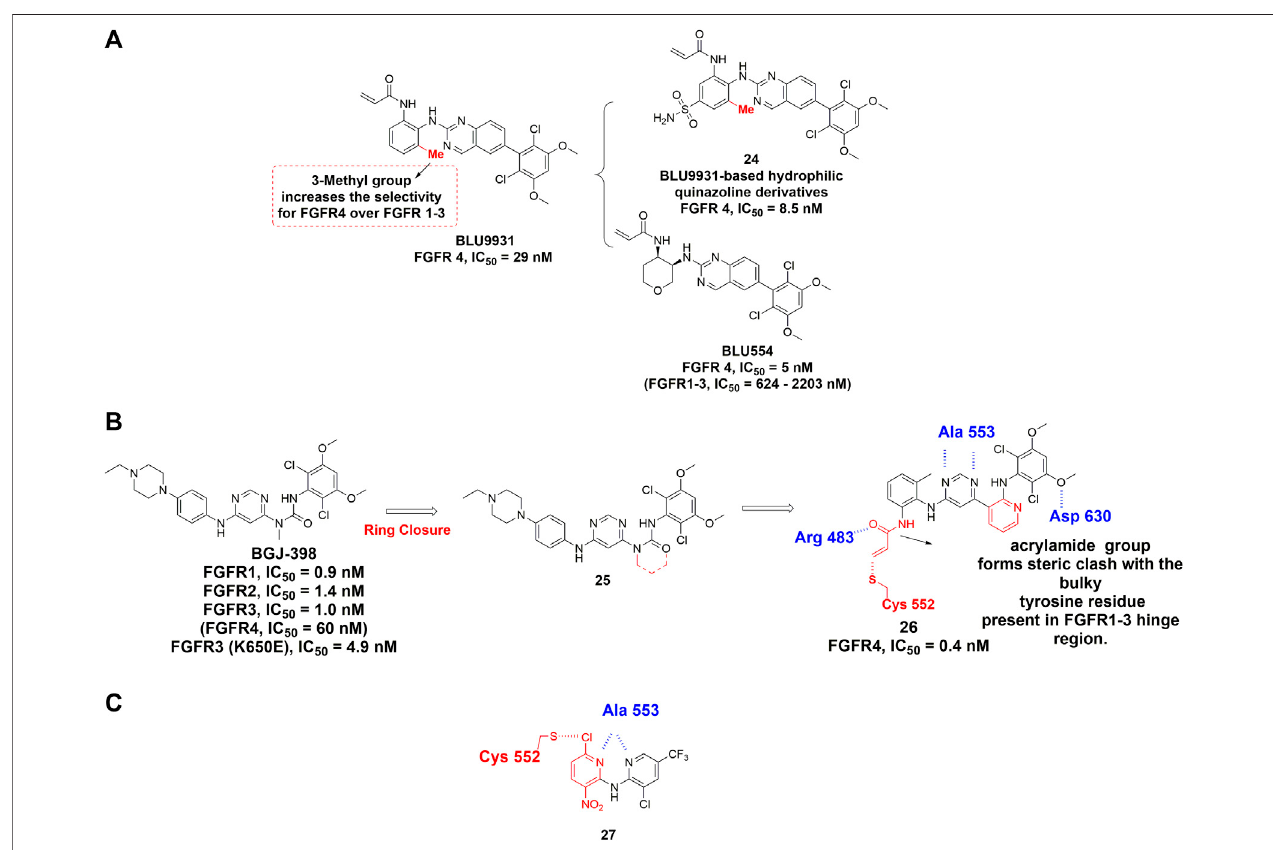
FIGURE 12 | (A) Structures of FGFR4 covalent inhibitors BLU9931 and its analogs. (B) Discovery of a covalent inhibitor of FGFR4 from BGJ-398 and summary of its interactions with FGFR 4 kinase domain. H-bonds are outlined by hashed blue line. Covalent binding contact is highlighted using red (PDB: 6JPE). (C) Discovery of dipyridylamine. The novel warhead is highlighted by red color and H-bonds are outlined by hashed blue line.